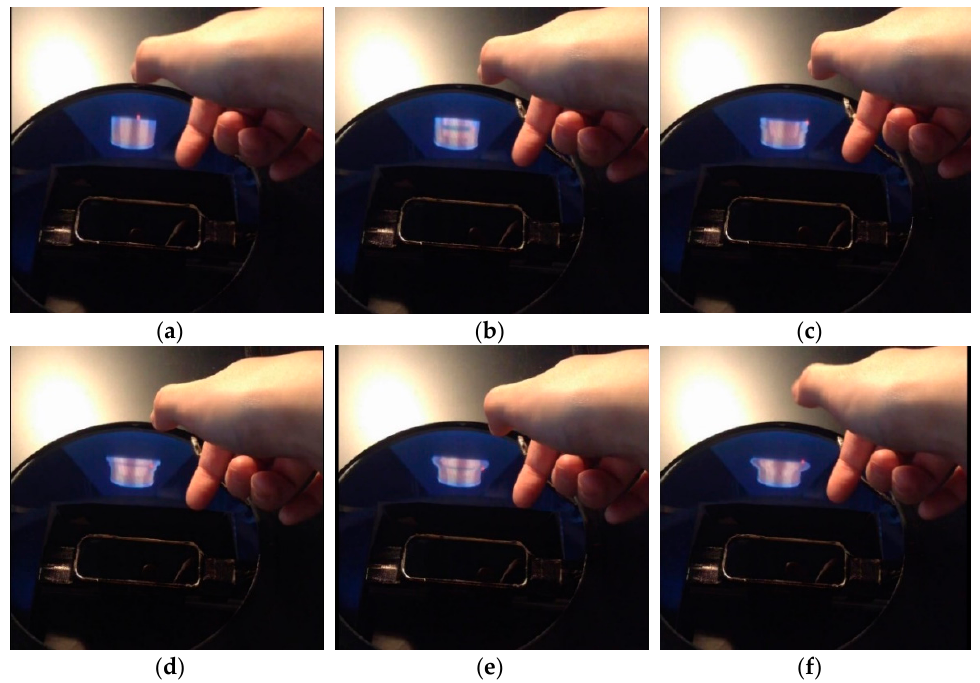
Figure 10. Shaping the external surface: ( a ) → ( b ) → ( c ) → ( d ) → ( e ) → ( f ). Figure 11.